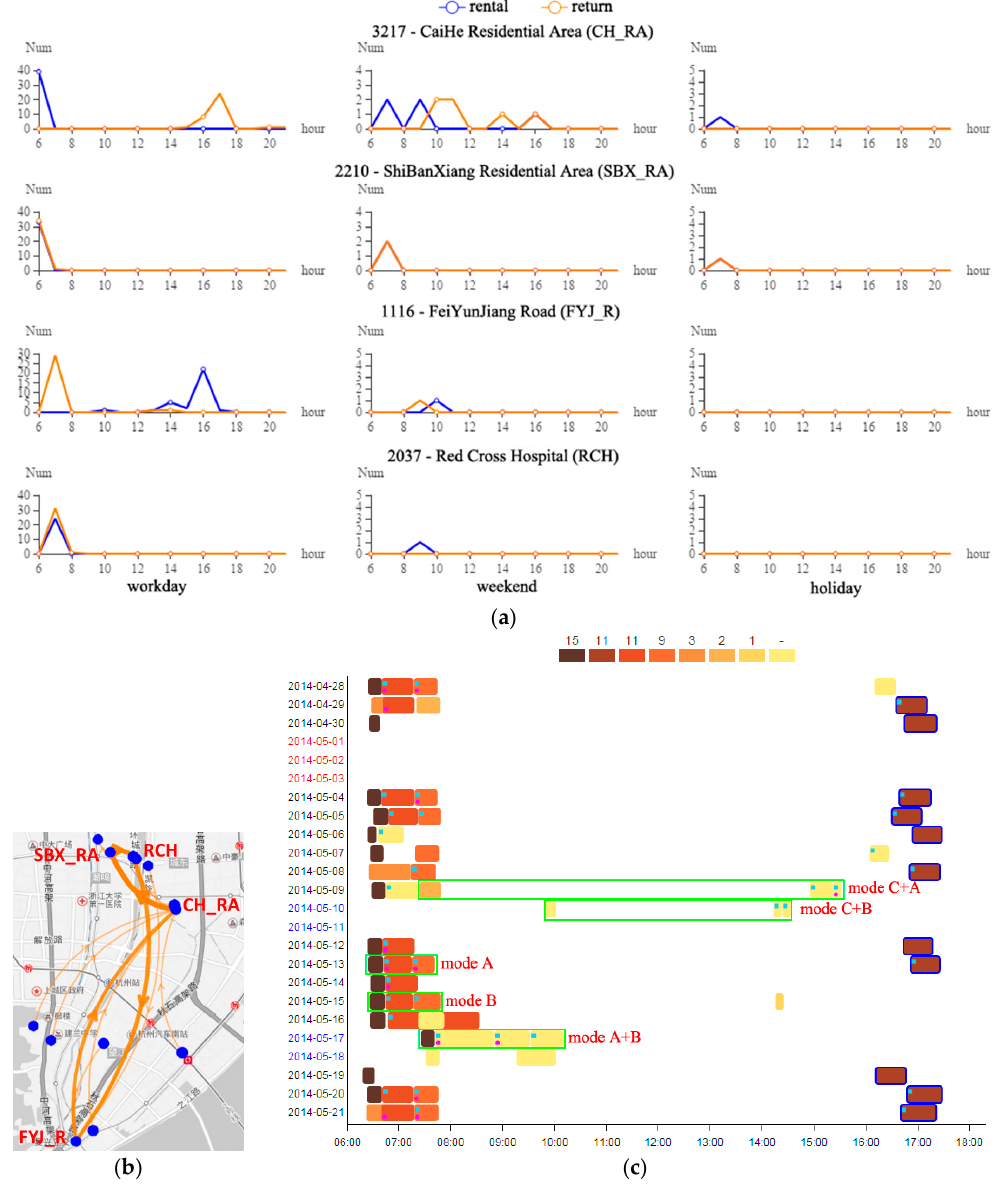
Figure 5. The process of inferring home and work locations in example A. ( a ) The station visited temporal view; ( b ) The trajectory aggregation map; ( c ) The user hire sequence view. Two optional glyphs are added on the horizontal bar if necessary. The blue square indicates that the return station of the previous trip (bar) is the same as the rental station of the next trip (bar), and the purple circle indicates that the bike used in contiguous trips has not changed. By using these glyphs, several hire modes can be determined (Figure 6). In mode A, the trips are contiguous and